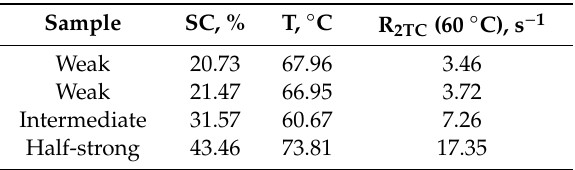
Table 2. Average values of the solids content (SC), measurement temperatures (T), and spin-spin relaxation rates R 2TC corrected to T ref = 60 ◦ C for several black liquor samples.